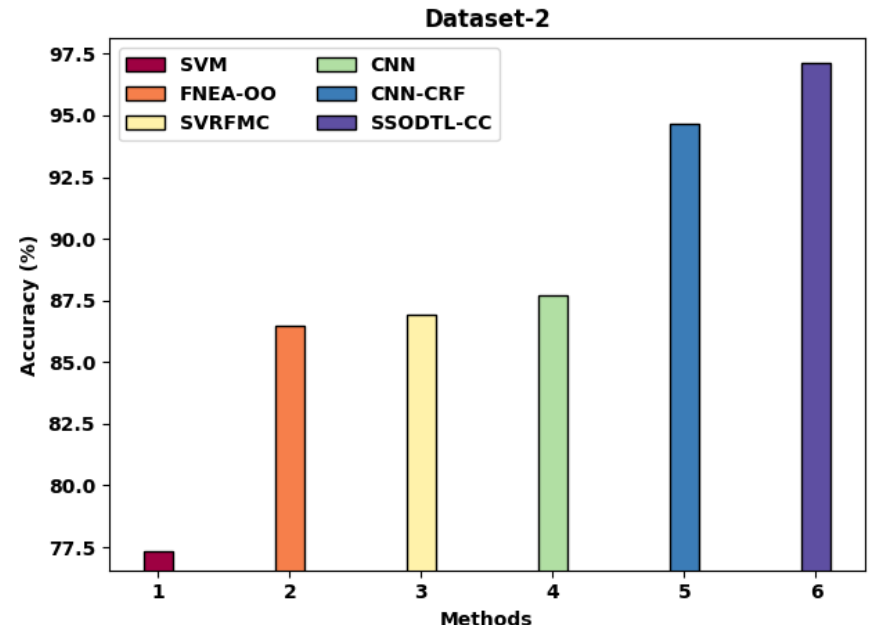
Figure 7. Comparative analysis of the SSODTL-CC technique under dataset-2.